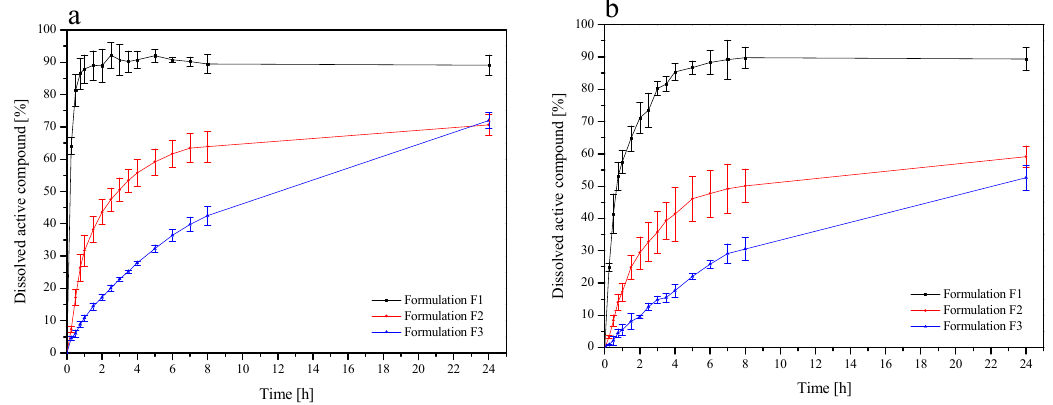
Figure 5. Dissolution profiles of chelidonine ( A ) and sanguinarine ( B ) from the chitosan tablets with Chelidonii herba lyophilized extract (F1–F3) at pH ~4.5.